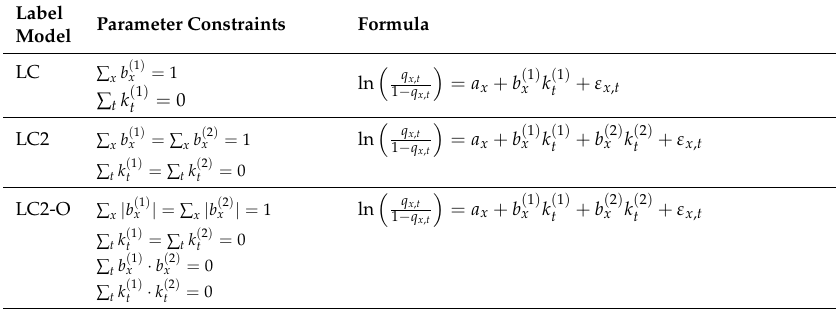
Table 2. List of the Lee–Carter models used in this study, with the acronyms, parameter constraints and